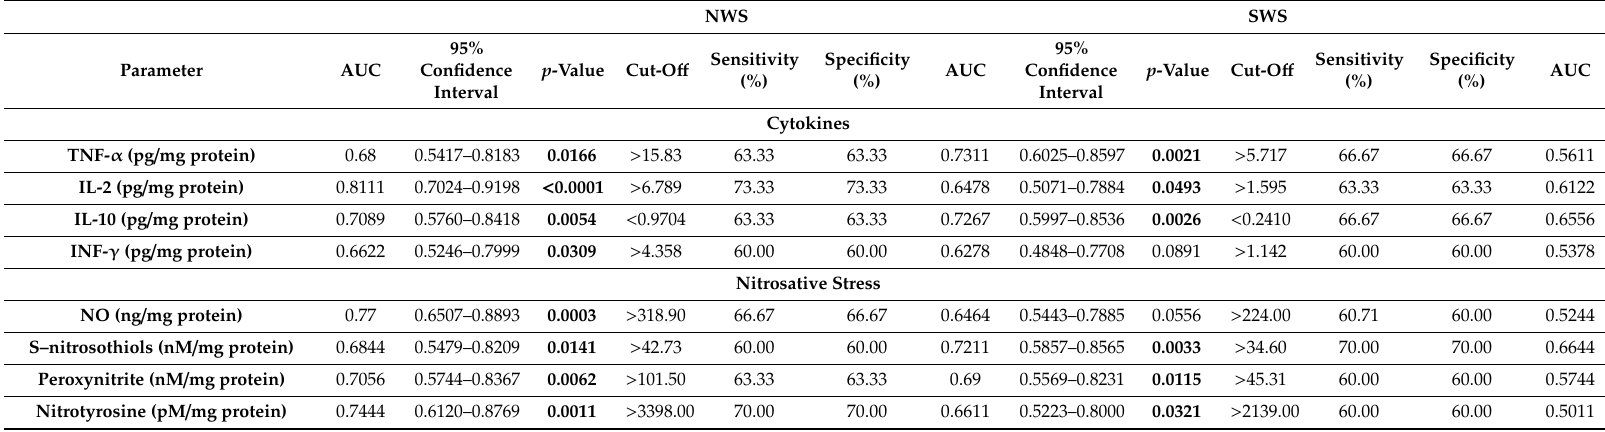
Table 2. ROC analysis of the assessed cytokines and nitrosative stress biomarkers in the saliva of plaque psoriasis patients with normal salivation and hyposalivation.